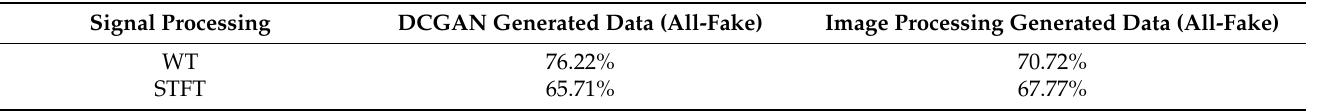
Table 10. Comparison of DCGAN and image processing techniques.